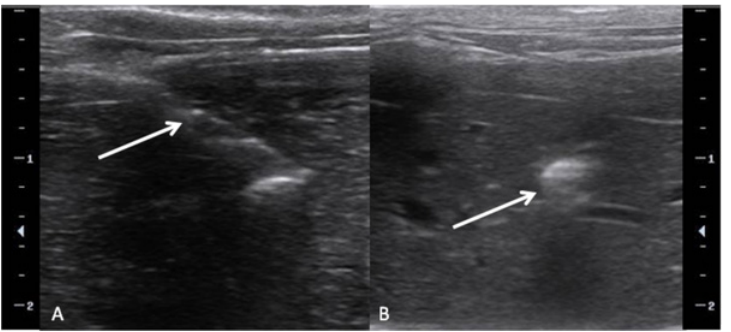
Fig 2. Ultrasound guided implantation. (A) Using ultrasound guidance, a 17 gauge coaxial introducer (arrow) is advanced into the liver. The sharp inner stylet is removed and a small tumor fragment (3-4mm 3 ) is placed in the hub of the introducer and pushed with the blunt stylet. (B) Post implantation US image reveals a small focus of hyperechogenicity (arrow) representing the tumor fragment and air.